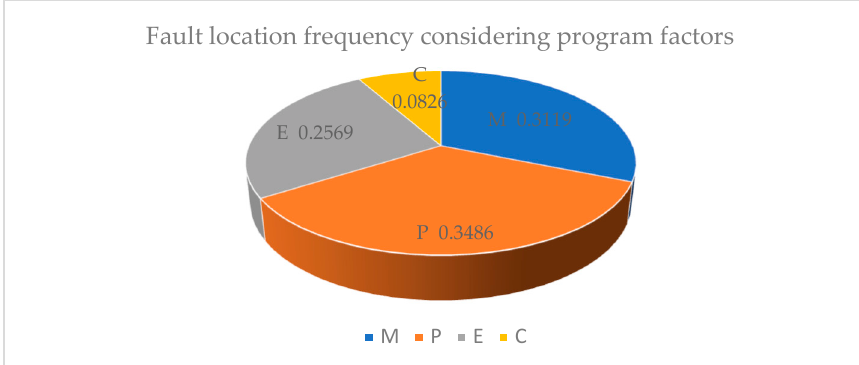
Figure 6. The frequency diagram of fault position of the loading and unloading truss robot for CNC punch considering program factors.